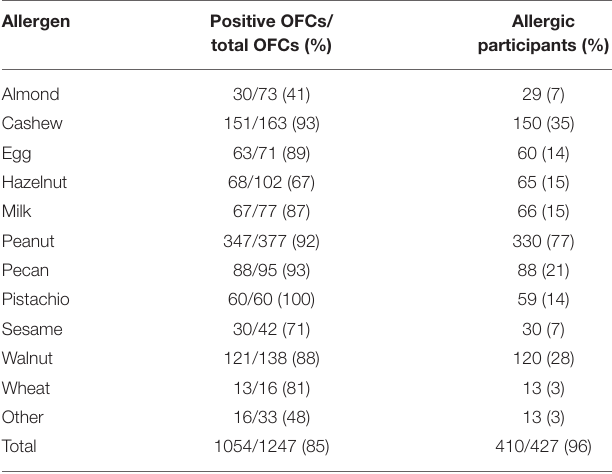
TABLE 2 | Challenge summary by